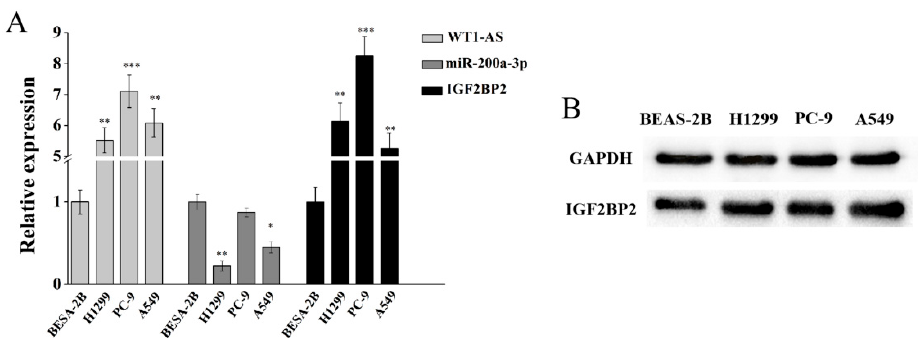
Figure 6. Validation of regulatory axis gene expression. ( A ) RT-PCR analysis detects the expression of WT1-AS, miR-200a-3p, and IGF2BP2 in LUAD cell lines. ( B ) The expression of IGF2BP2 protein in LUAD cell lines was detected by Western blot. * p < 0.05, ** p < 0.01, *** p < 0.001, by unpaired Student t test compared with control group.